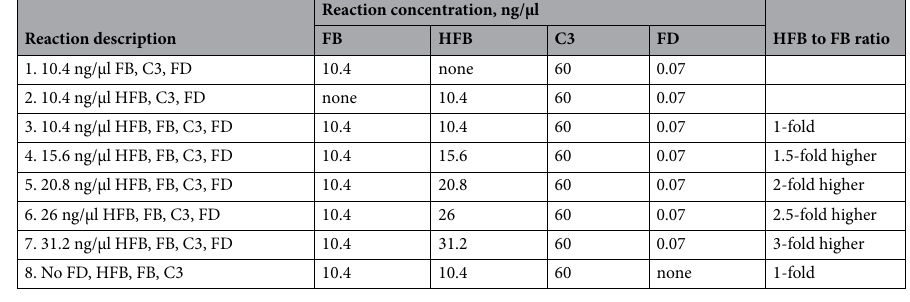
Table 1. Concentrations of AP proteins and HFB in reactions using purified complement components. The description summarizes the proteins included in the reaction and the changes in HFB concentration. Reaction concentrations for each protein are in the center columns. The HFB to FB ratio describes changes in HFB concentrations to FB concentration. The reactions were in EGTA/MgCl 2 buffer and activation occurred over 15 min at 37 °C. The results are shown in Fig.